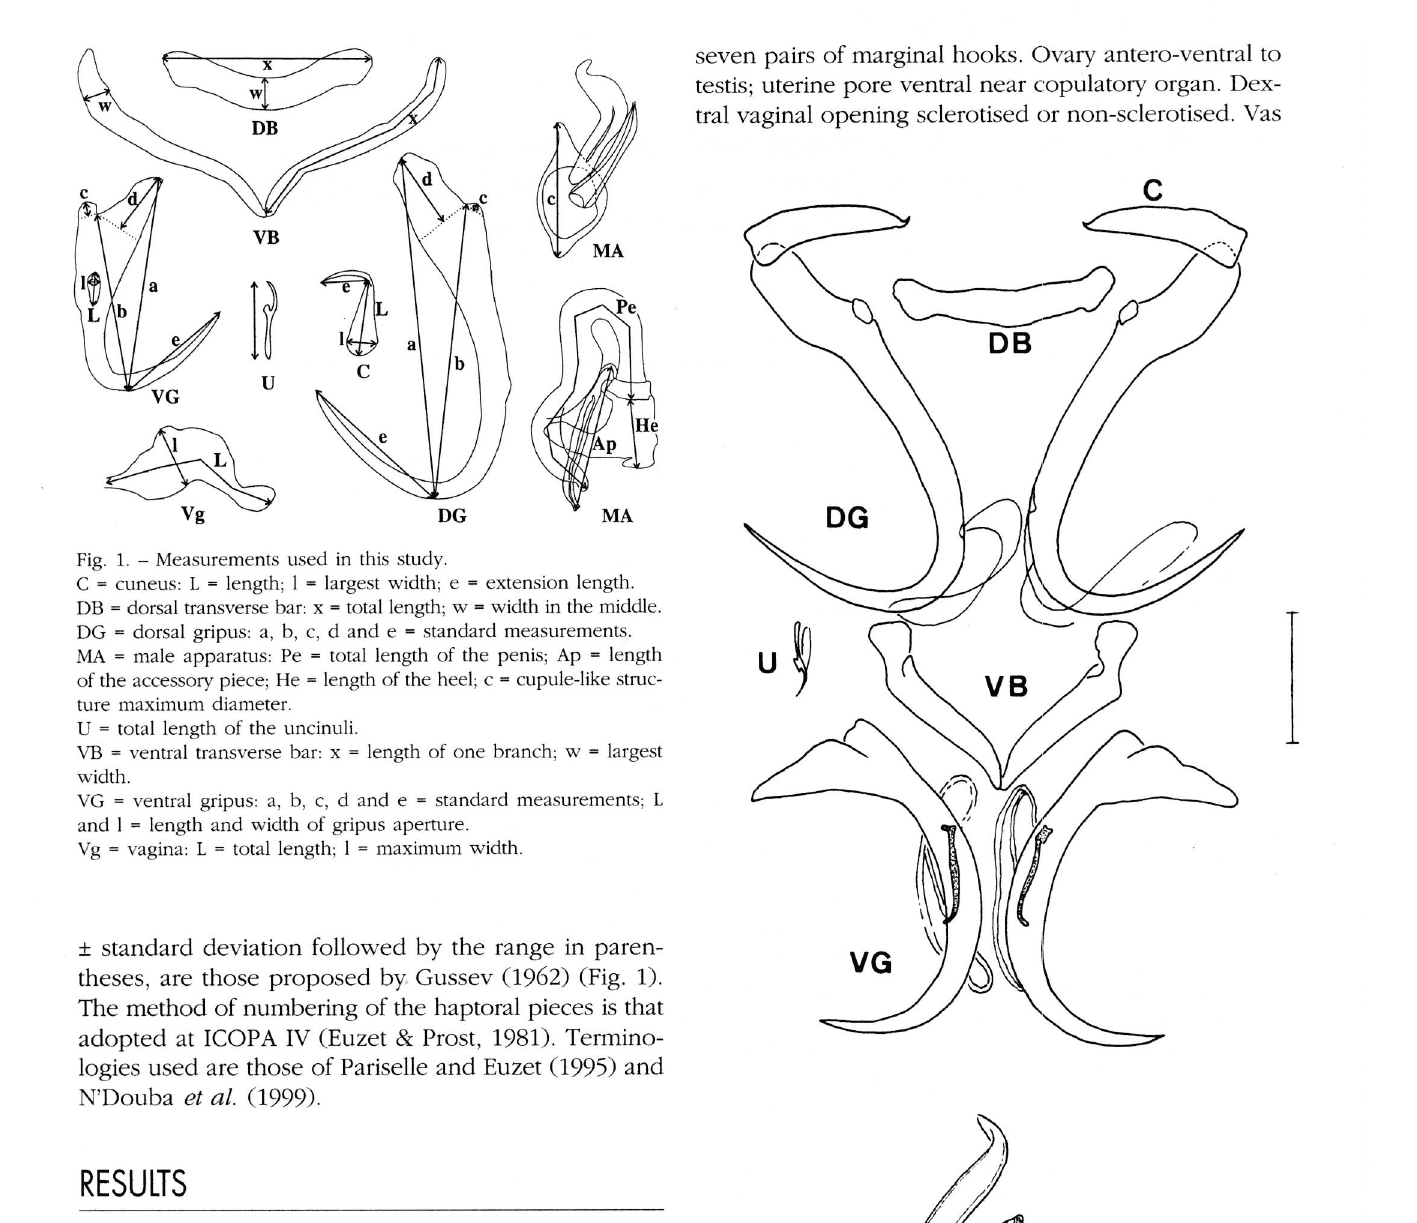
Fig. 1 . - Measurements used in this study. C - cuneus; L = length; 1 - largest width; e = extension length. DB - dorsal transverse bar: x = total length; w = width in the middle. DG - dorsal gripus: a, b, c, d and e = standard measurements. MA = male apparatus: Pe - total length of the penis; Ap = length of the accessory piece; He = length of the heel; c = cupule-like struc ture maximum diameter. U = total length of the uncinuli.